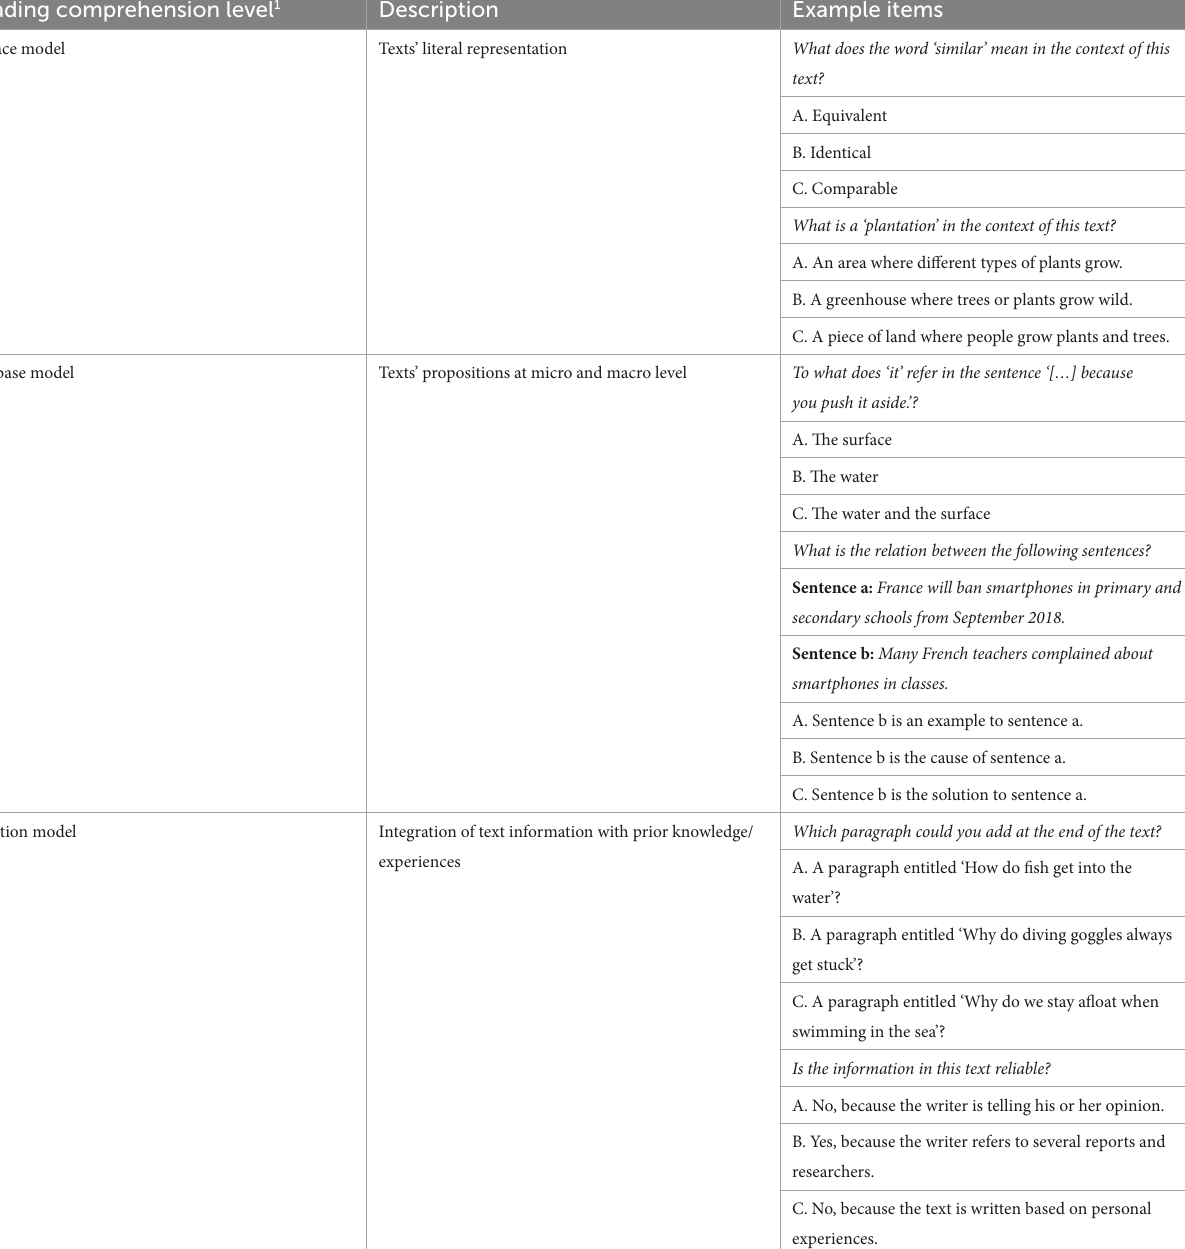
TABLE 2 Example items according to the three reading comprehension levels (translated from